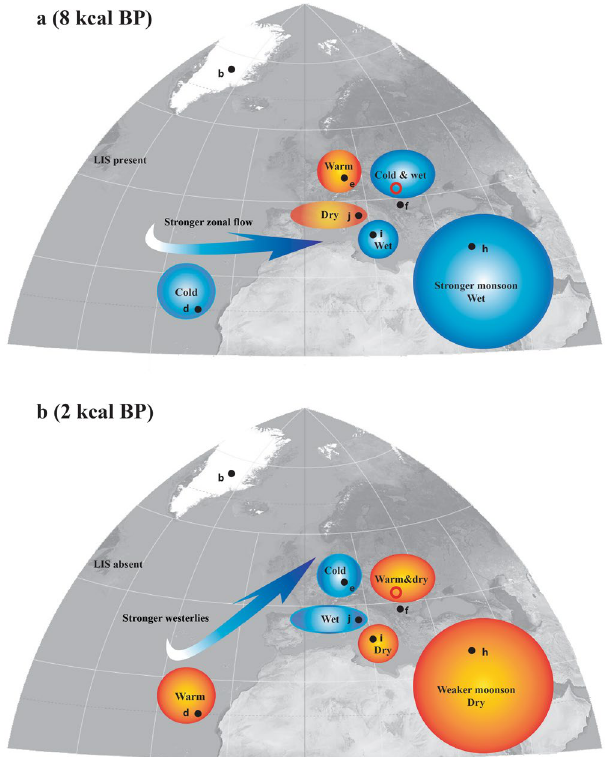
Figure 4. Climatic conditions in Europe during the Holocene. ( a ) At 8 kcal BP (representative for conditions similar to those occurring during the negative phase of the NAO). ( b ) At 2 kcal BP (representative for conditions similar to those occurring during the positive phase of the NAO). Black circles and letters refer to the location of paleoclimatic archives discussed in the text and presented in Fig. 3. Position of Scărișoara Ice Cave (this study) is marked by a red circle. Map produced using Adobe Illustrator CS6 (http://www.adobe.com/products/illustrator. html). The background map is cropped from the world map (Mollweide projection; the imagery is a